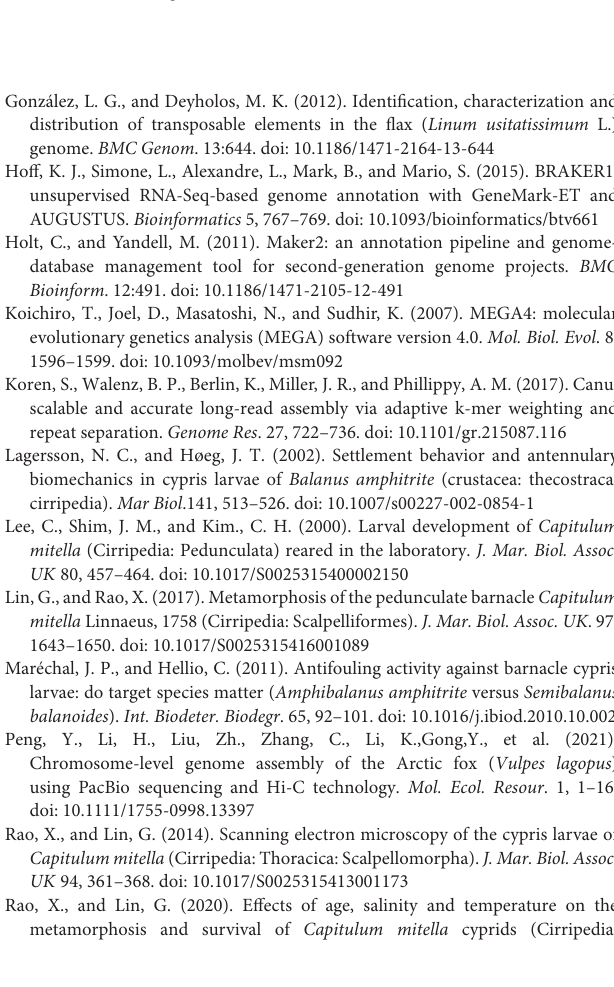
Supplementary Figure 1 | The karyotype of C. mitella . Supplementary Table 1 | Repetitive element annotations in C. mitella . Supplementary Table 2 | Repetitive element